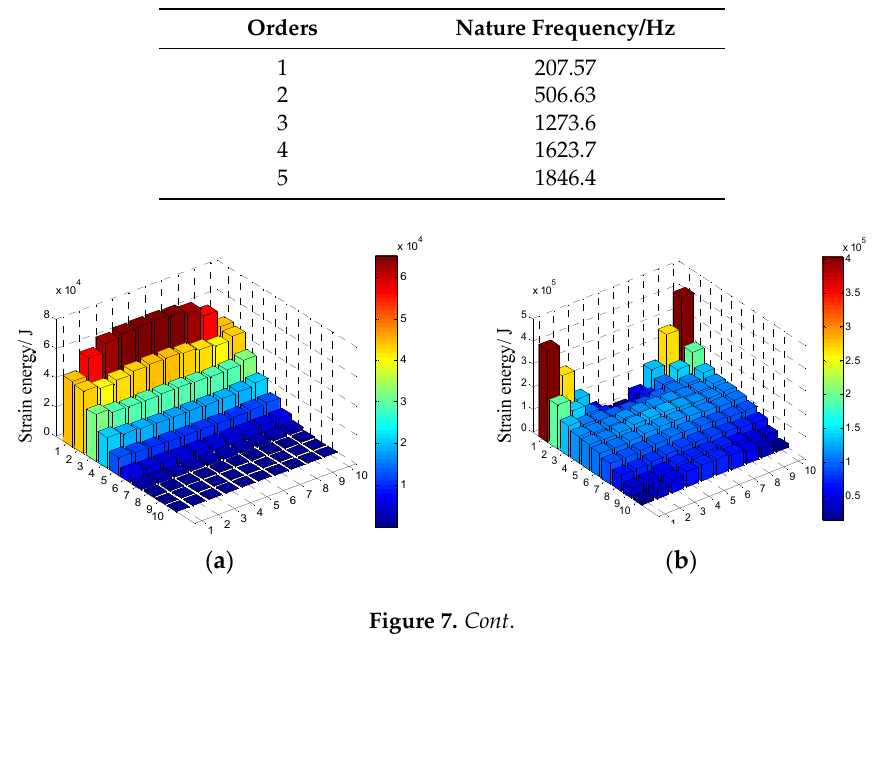
Table 4. The first five natural frequencies of thin plate structure.